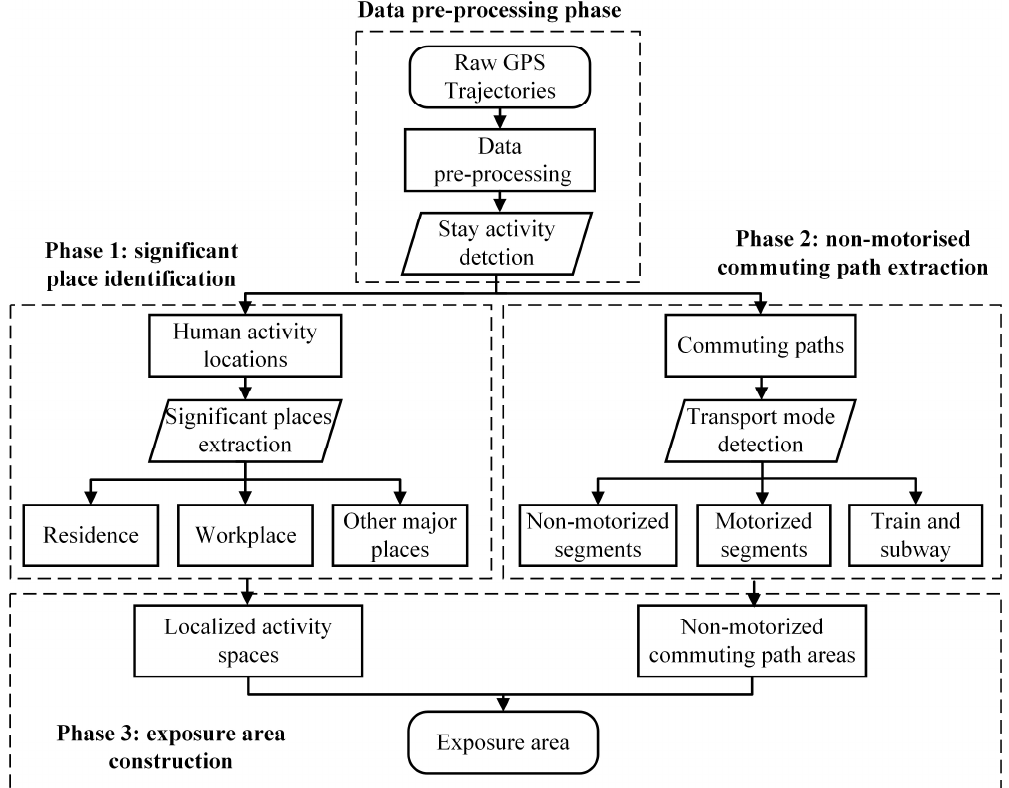
Figure 2. The methodology flowchart.